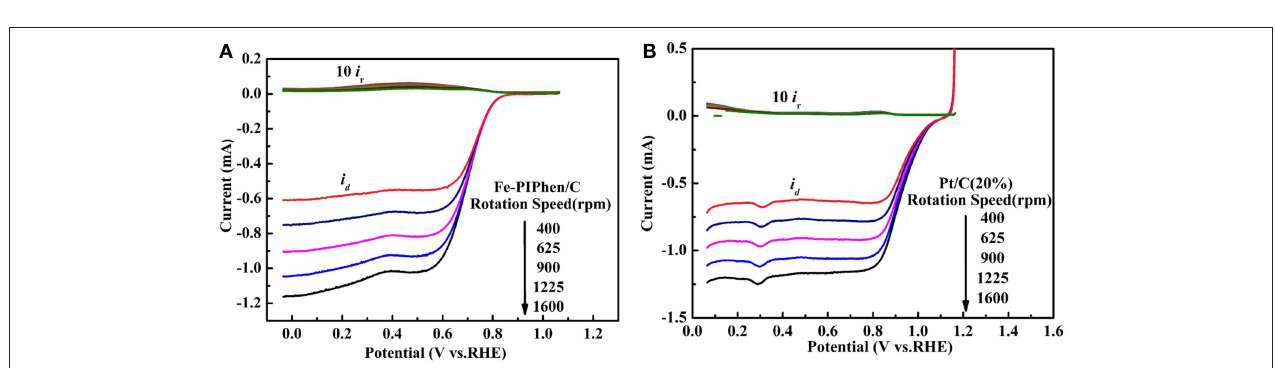
cm 2 · s − 1 ), and υ is the kinematic viscosity of the electrolyte (0.01